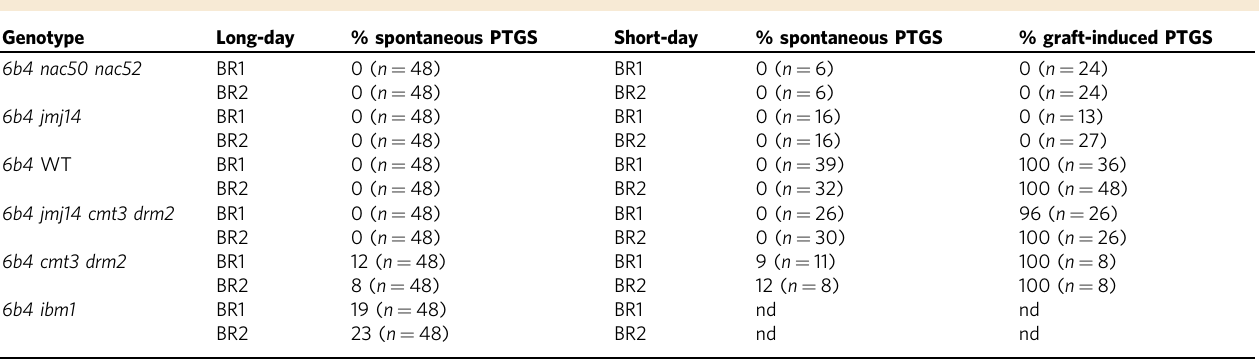
Table 1 Frequency of spontaneous and graft-induced